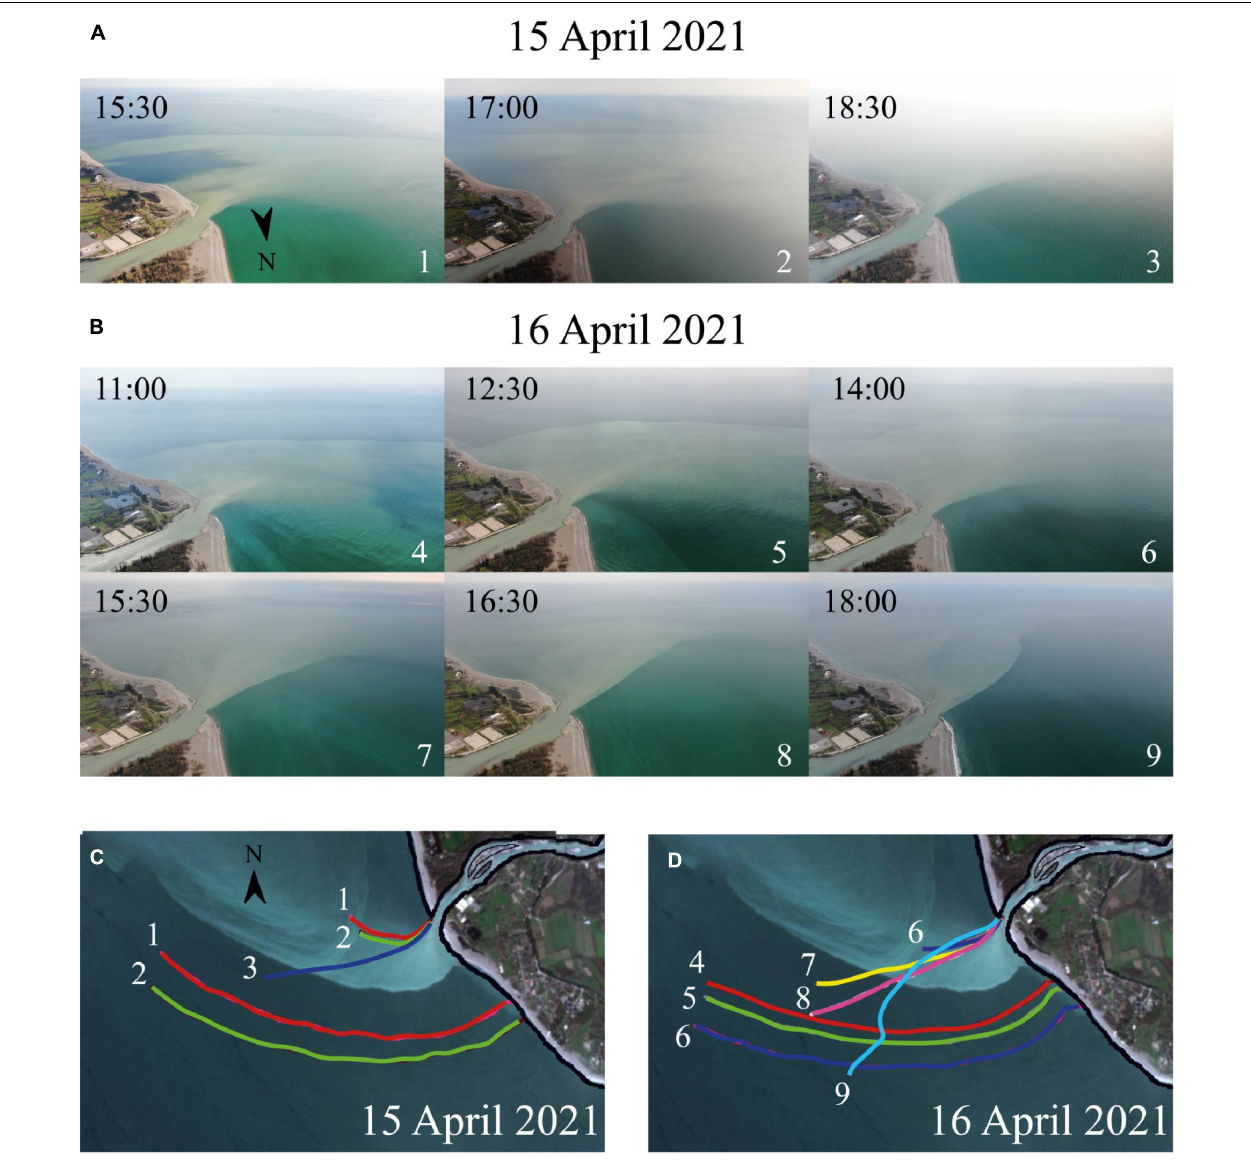
FIGURE 3 | Change of spreading direction of the Bzyb plume registered by aerial observations (A,B) and at the respective georeferenced images (C,D) on 15 April 2021 (A,C) and 16 April 2021 (B,D) . Colored lines and numbers in panels (C,D) represent the subsequent locations of the Bzyb plume border at time periods shown in panels (A,B) , respectively. The background image in panels (C,D) is the Sentinel-2 satellite image of the study area acquired on 15 April 2021 at